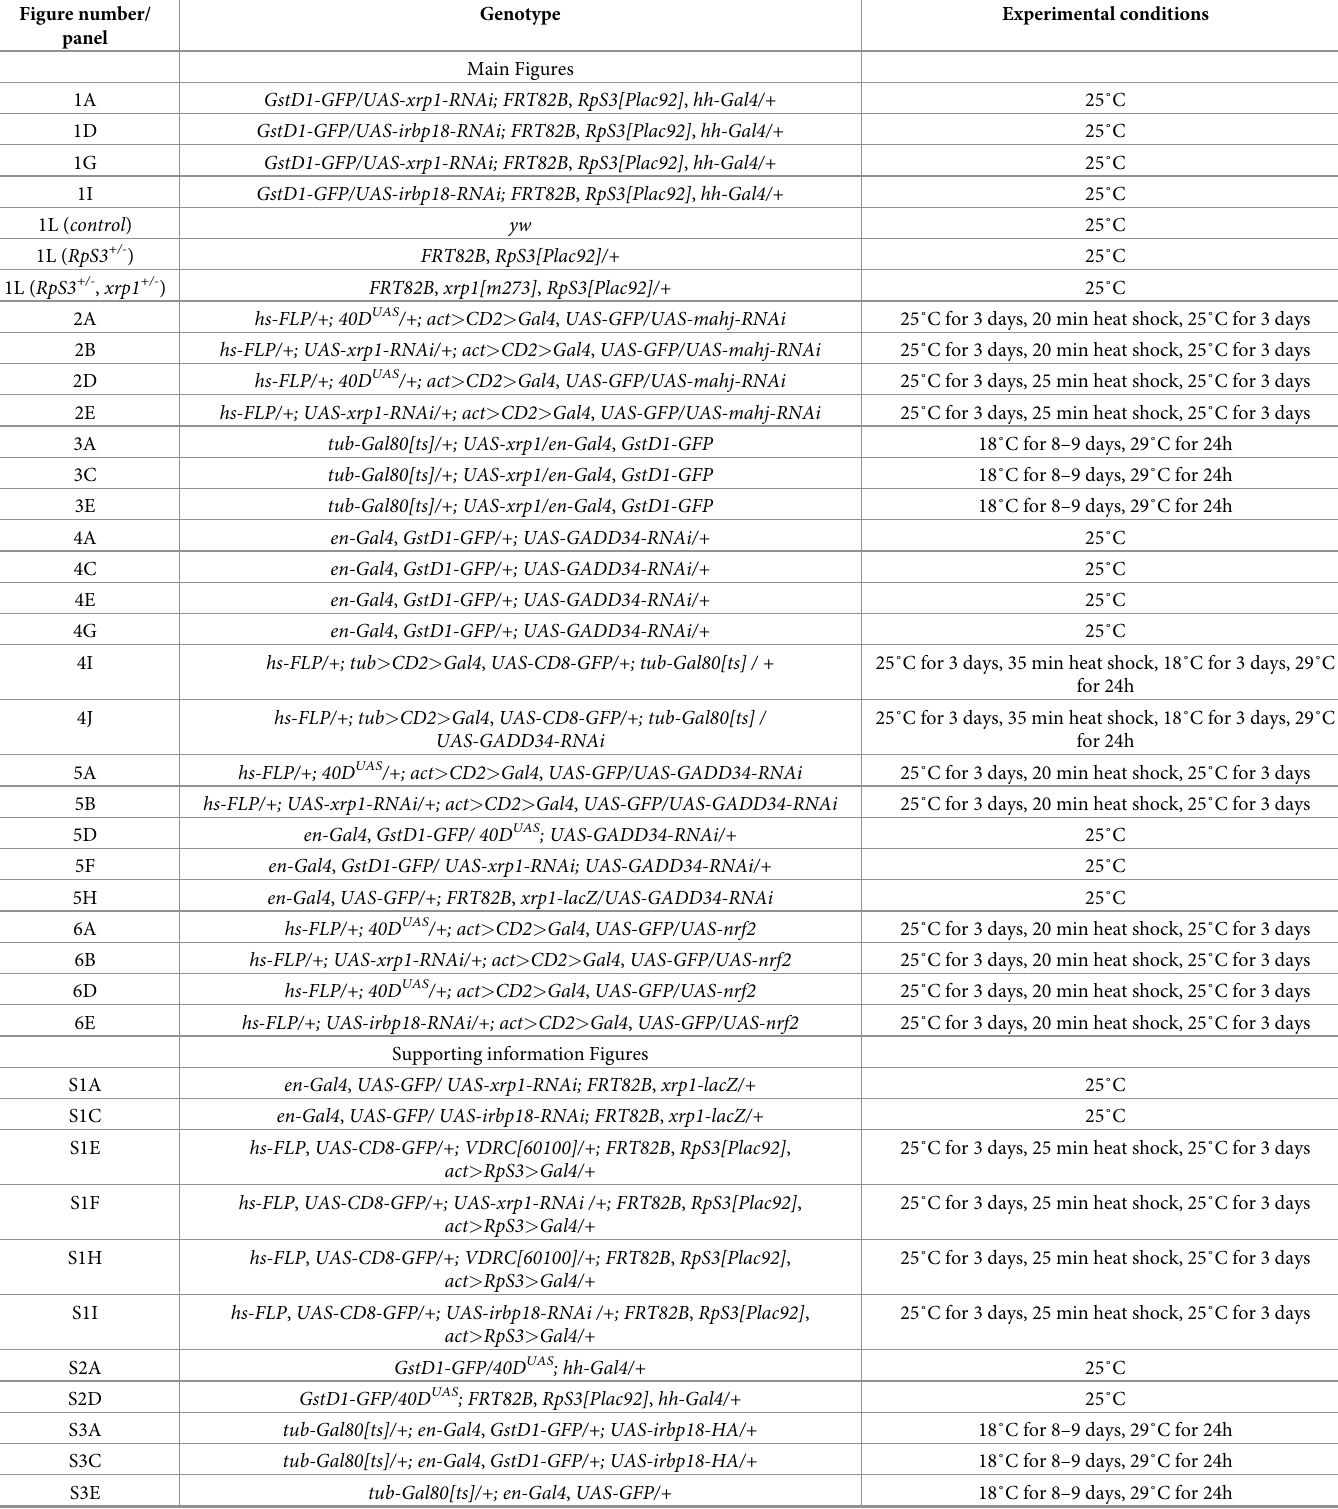
Table 1. Genotypes Table. Figure number/